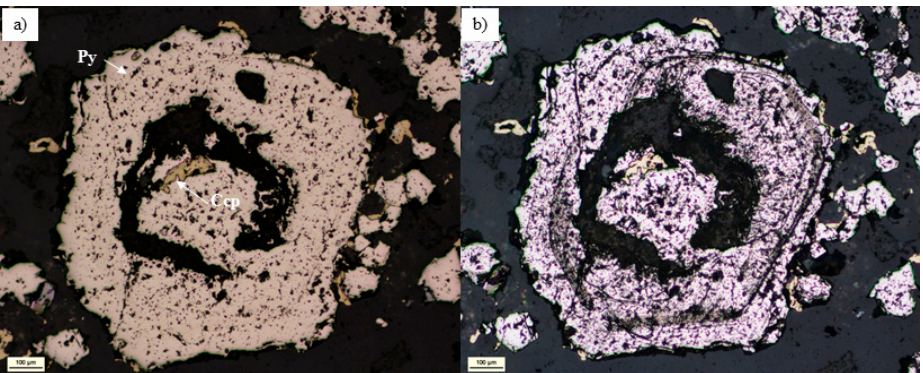
Figure 2. Microphotographs of gold ore samples. Reflected light microscopy of the etching of pyrite grains ( a ) before and ( b ) after etching in HNO 3 solution. Ccp is chalcopyrite and Py is pyrite.